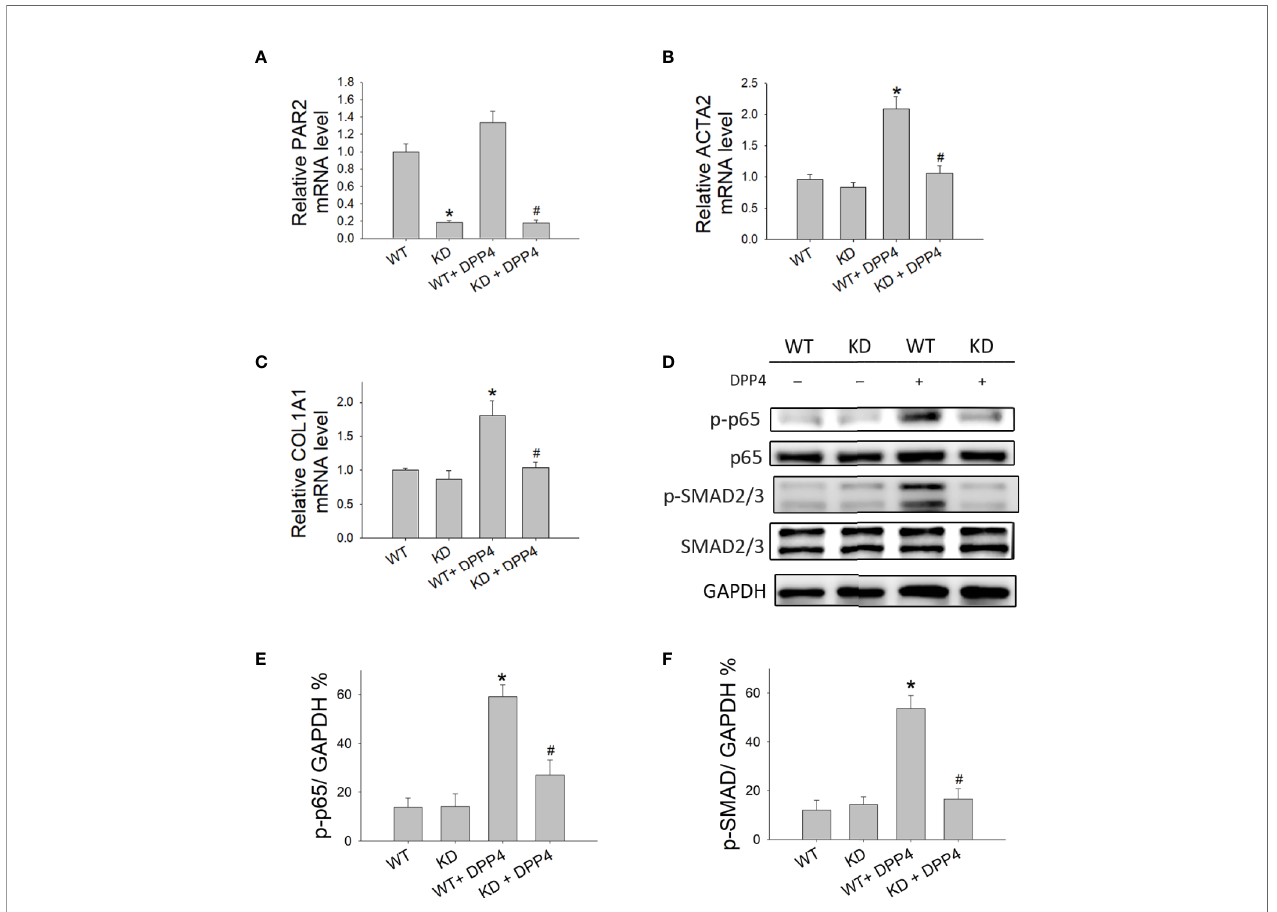
FIGURE 7 | Effects of PAR2 knocked down on the activation of fi broblasts in human dermal fi broblast. Wild-type (WT) and PAR2 knockdown (KD) human dermal fi broblast were treated with recombinant DPP4 (200 ng/ml). Gene expression was determined by RT-qPCR. (A) PAR2, (B) ACTA2, and (C) COL1A1 mRNA expression were determined. (D) Protein expression was determined using Western blotting. Calculated ratios of (E) NF- k B p-p65 to GAPDH, (F) p-SMAD2/3 to GAPDH were shown. (n=4) * p <0.05 vs. WT, # p <0.05 vs. WT +